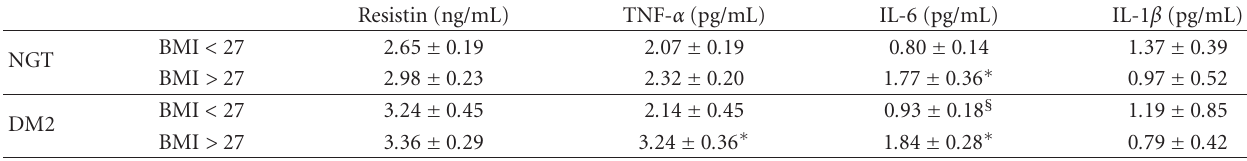
Table 4: Circulating resistin, TNF- α , IL-6, and IL-1 β protein levels between the subgroups of the NGT- and the DM2-women.